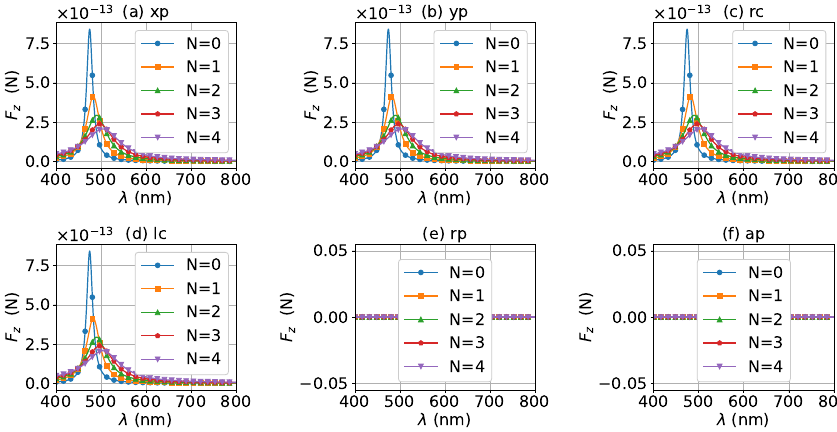
Figure 12. The axial optical force F z exerted on a graphene-coated gold nanosphere by a zeroth-order vector Bessel beam as a function of wavelength with various layer numbers N . The half-cone angle is α 0 = 0 ◦ .